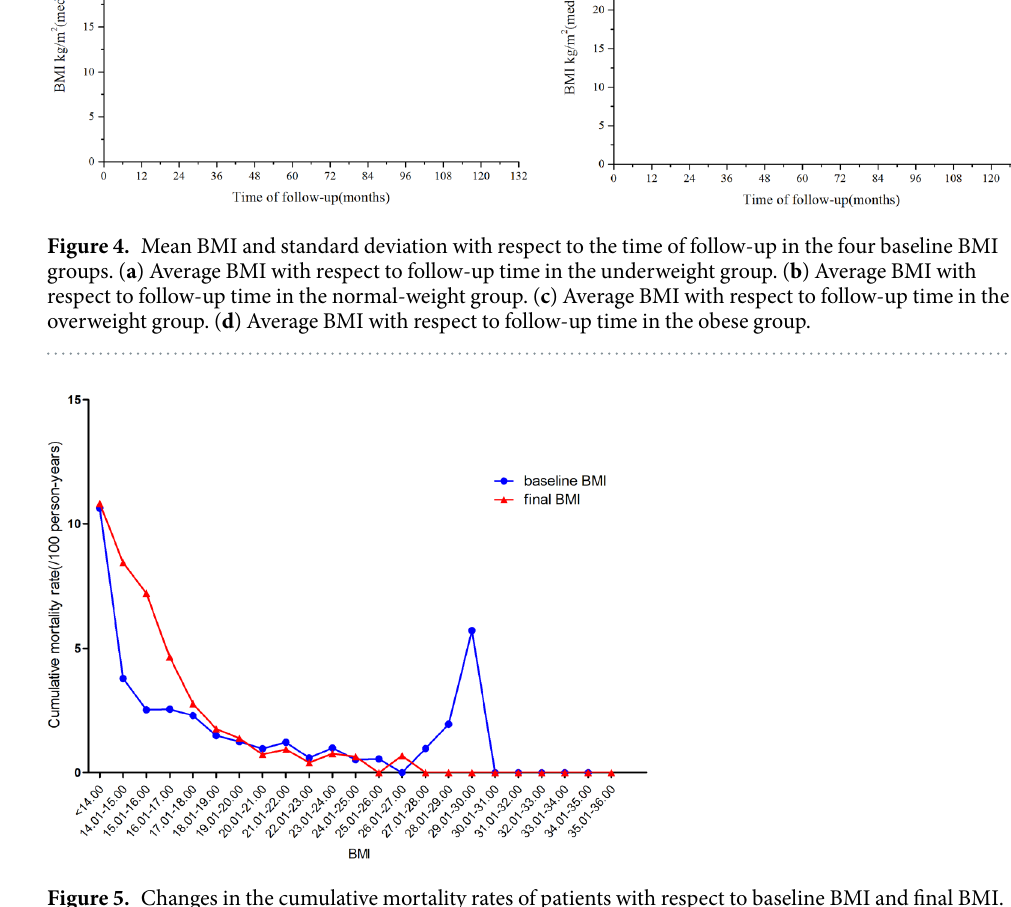
Figure 5. Changes in the cumulative mortality rates of patients with respect to baseline BMI and final